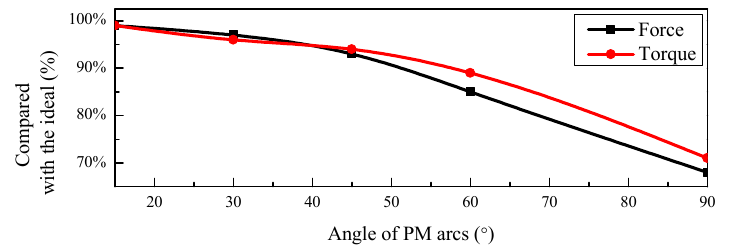
Figure 13. Influences of different PM arc angles on the thrust force and torque.